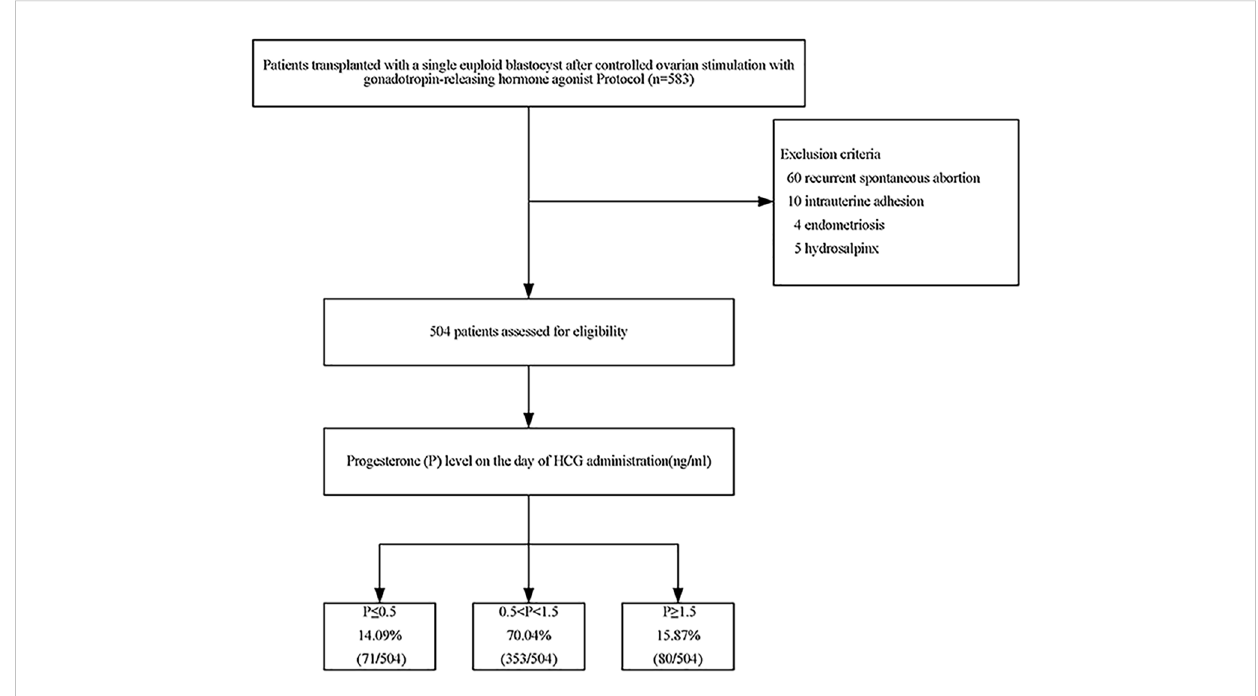
FIGURE 1 Flowchart of